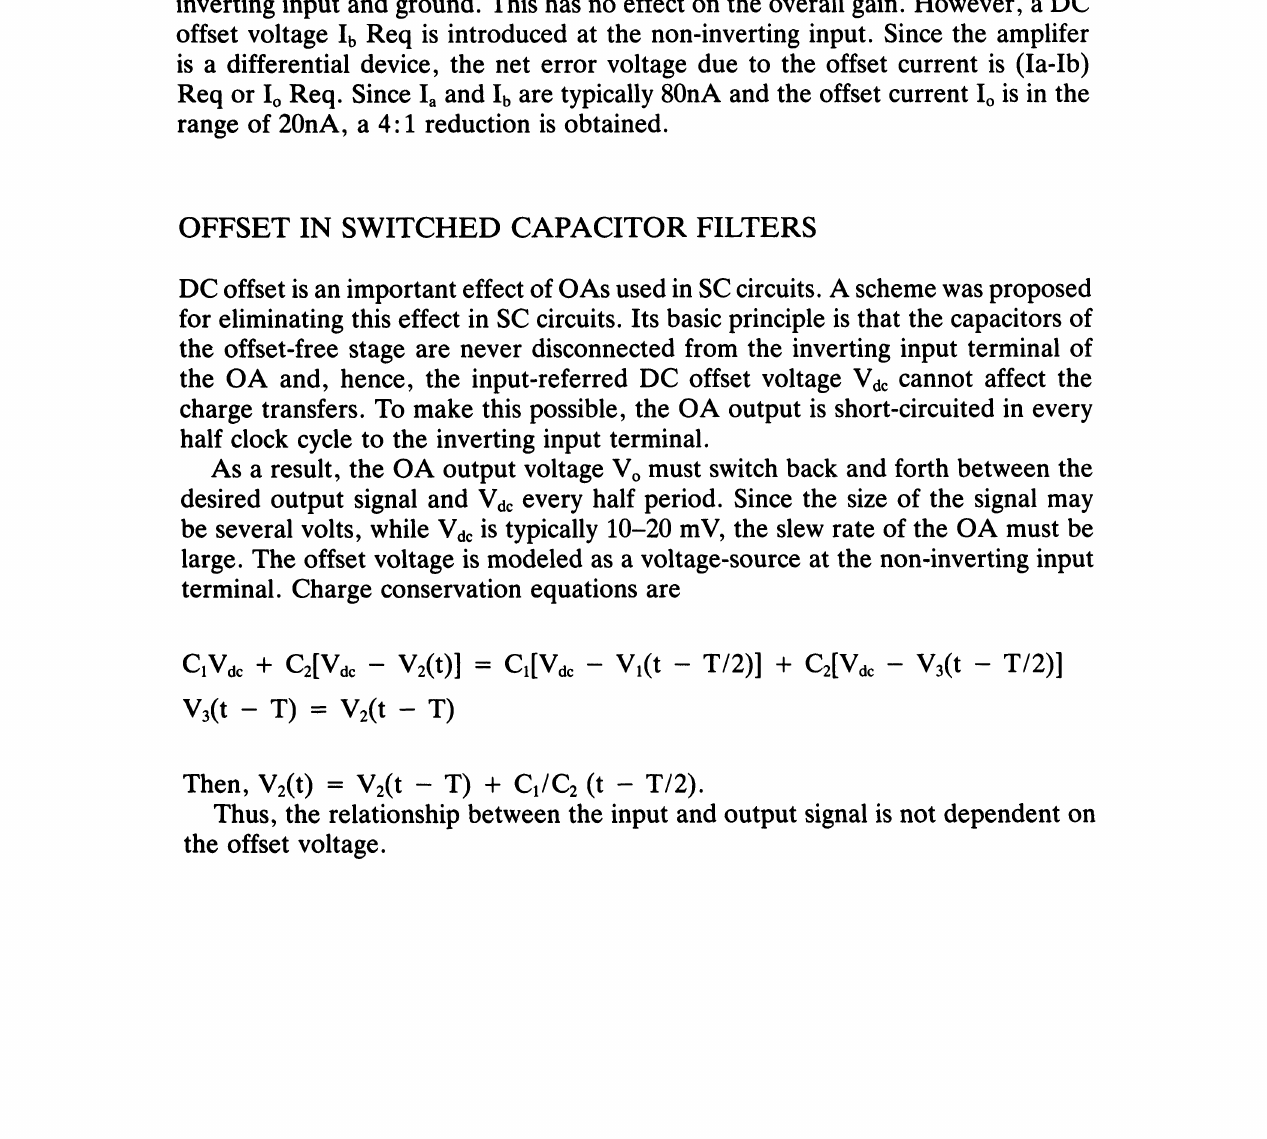
FIGURE 1.10 Biquad using Miller Inverter